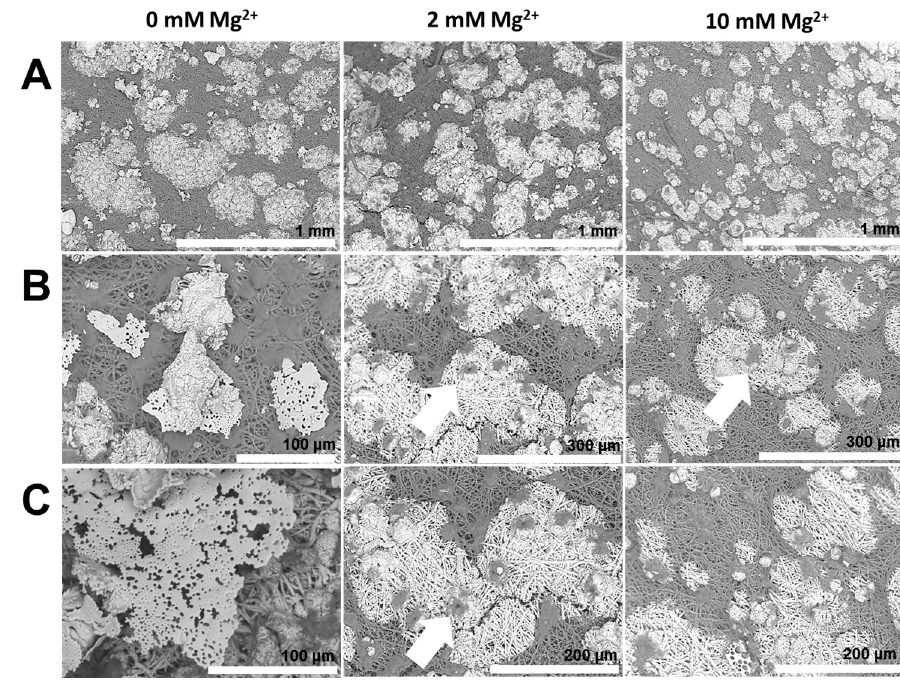
Figure 8. Representative SEM images of outer surfaces of egg shell membranes mineralized in the presence of PAA 35000 (50 ppm) and different Mg 2+ contents. Arrows indicate the exclusion of mammillae from crystallization.